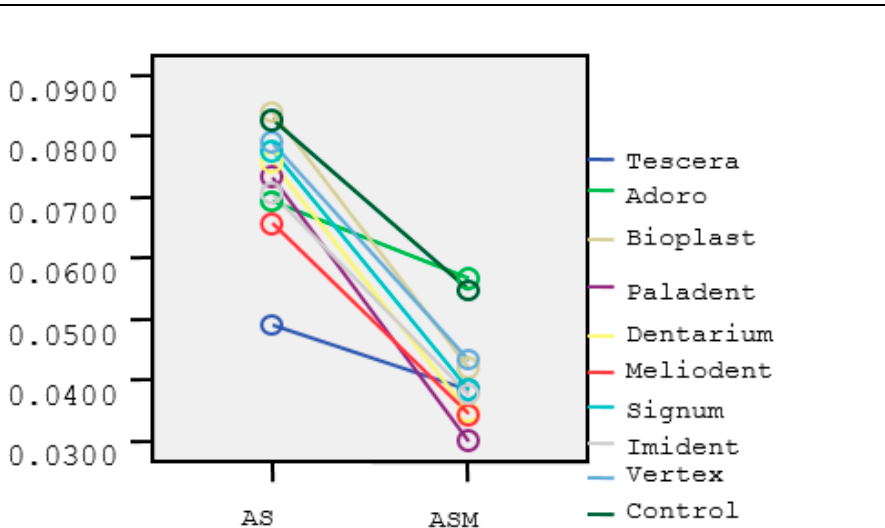
Figure 1. Estimated marginal means of absorbant index of the groups in the incubation periods. Different colors shows the absorbant values of the materials (T, A, B, P, D, M, S, I, V) and the control group.